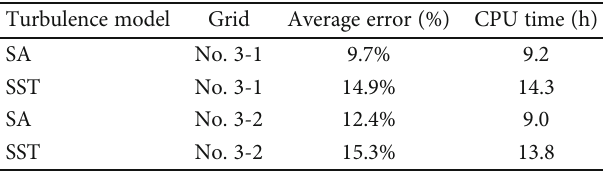
Figure 8: Dimensionless heat fl ux distribution on the surface of blunt biconic. Table 4: Stagnation point heat fl ux ð kW/m 2 Þ